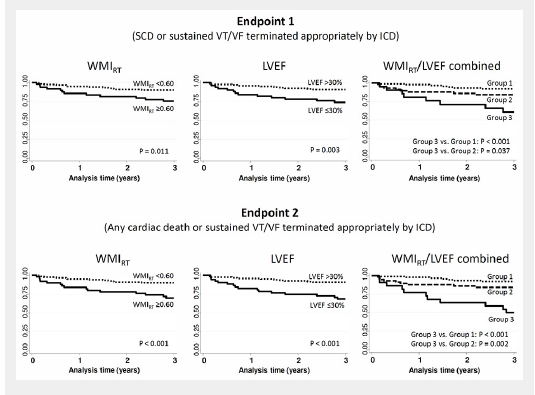
Figure 3 Kaplan-Meier survival estimates for Wedensky modulation index (WMI RT ), left ventricular ejection fraction (LVEF) and the combination of both predictors (Group 1 = WMI RT <0.60 and